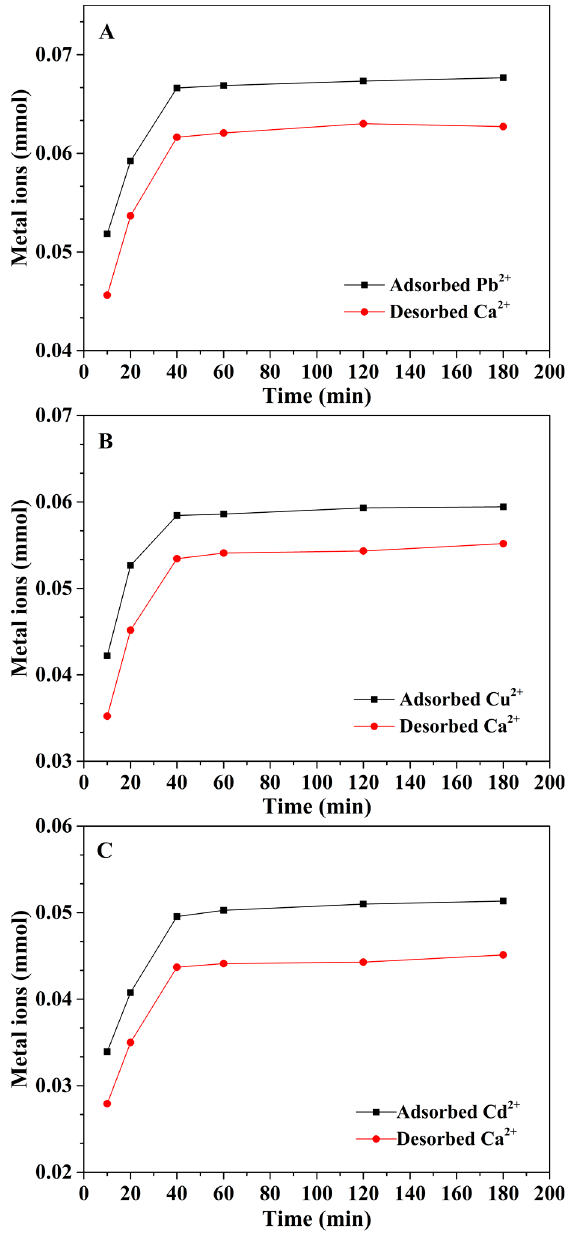
Figure 9. The mole amount of ( A ) Pb 2+ , Ca 2+ , ( B ) Cu 2+ , Ca 2+ and ( C ) Cd 2+ , Ca 2+ in different adsorption times.